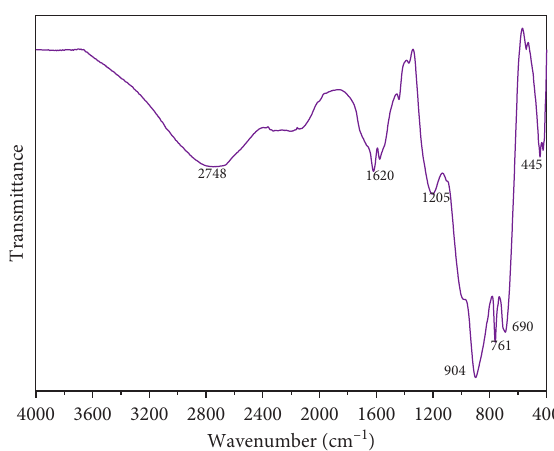
Figure 8: FTIR spectrum of